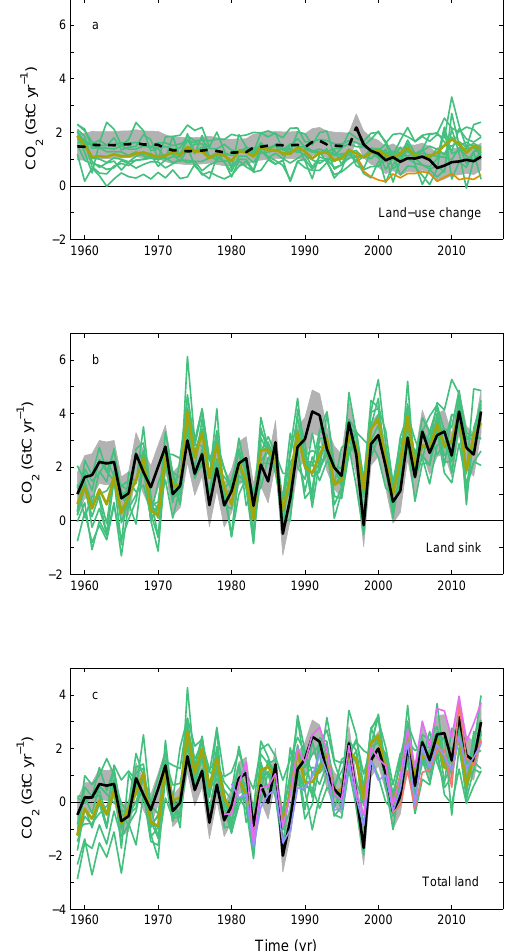
Figure 6. (a) Comparison of the atmosphere–land CO 2 flux show- ing budget values of E LUC (black). CO 2 emissions from land-use change showing individual DGVM results (green) and the multi- model mean (olive), as well as fire-based results (orange); land-use- change data prior to 1997 (dashed black) highlight the start of satel- lite data from that year. (b) Land CO 2 sink ( S LAND ; black) showing individual DGVM results (green) and multi-model mean (olive). (c) Total land CO 2 fluxes (b – a) from DGVM results (green) and the multi-model mean (olive); atmospheric inversions of Cheval- lier et al. (2005; MACC, v14.2) (purple), Rödenbeck et al. (2003; Jena CarboScope, s81_v3.7) (violet), and Peters et al. (2010; Car- bon Tracker, vCTE2015) (salmon) (see Table 6); and the carbon balance from Eq. (1) (black). In (c) the inversions were adjusted for the pre-industrial land sink of CO 2 from river input, by adding a sink of 0.45GtCyr − 1 (Jacobson et al., 2007). This adjustment does not take into account the anthropogenic contribution to river fluxes (see Sect. 2.7.2).